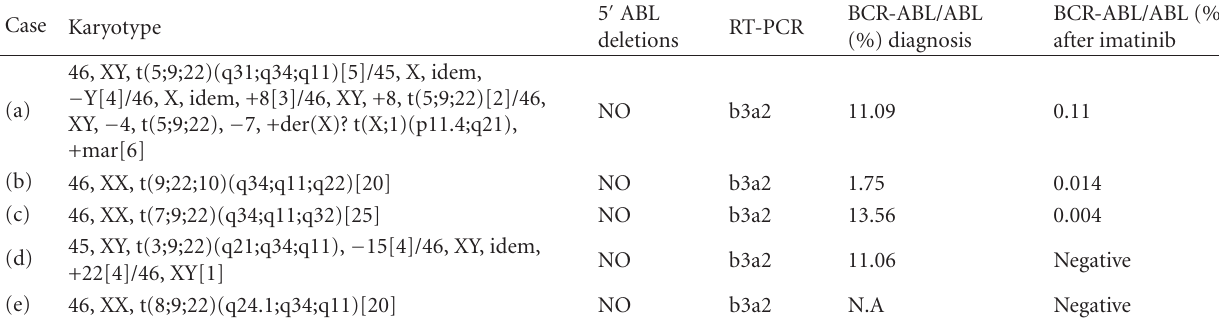
Table 2: Cytogenetic and molecular